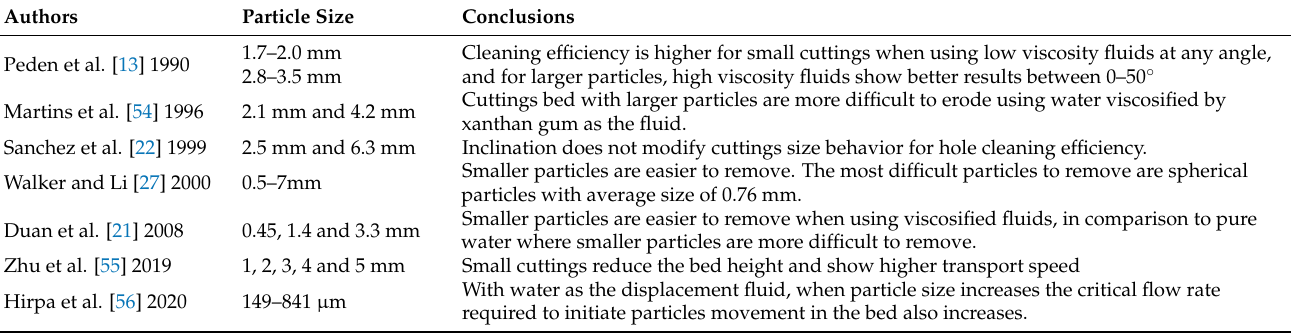
Table 1. Cuttings size study development along